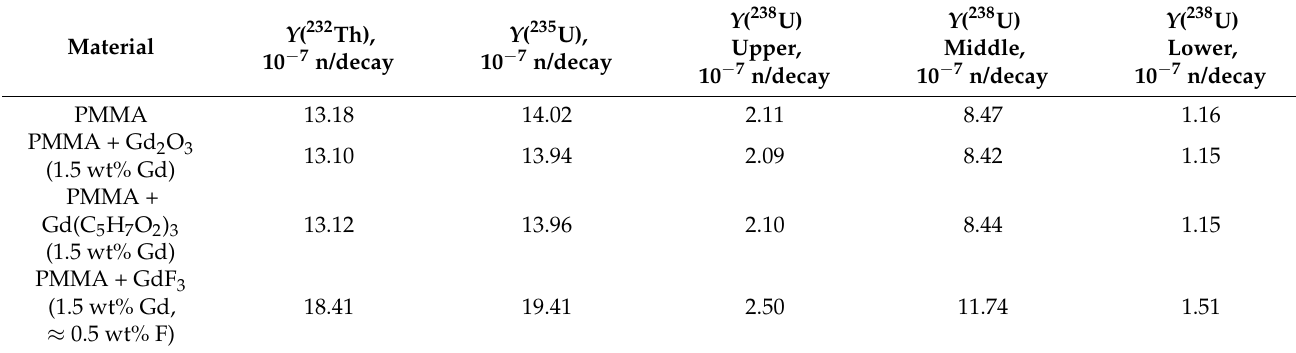
Table 1. Comparison of neutron yields * from ( α , n ) reactions for pure polymethylmethacrylate (PMMA), PMMA with gadolinium oxide (1.5 wt% Gd), PMMA with gadolinium acetylacetonate (1.5 wt% Gd) and PMMA with gadolinium fluoride (1.5 wt% Gd).